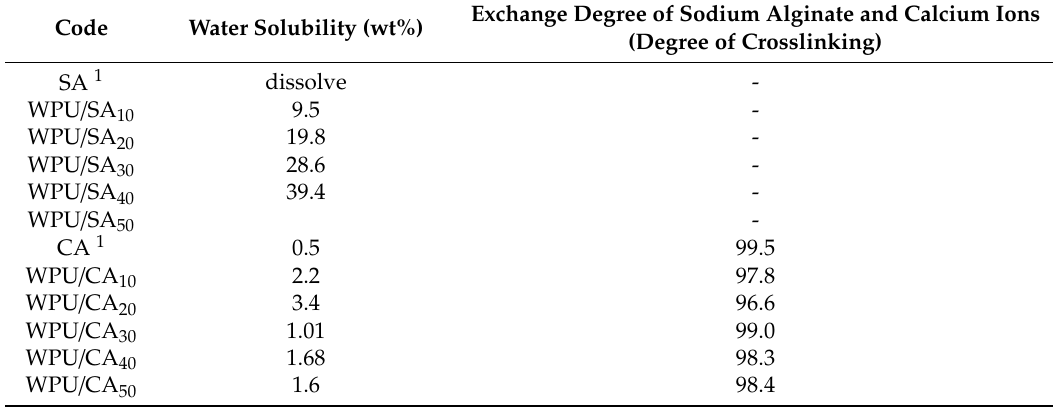
Table 1. Water solubility of the WPU / CA